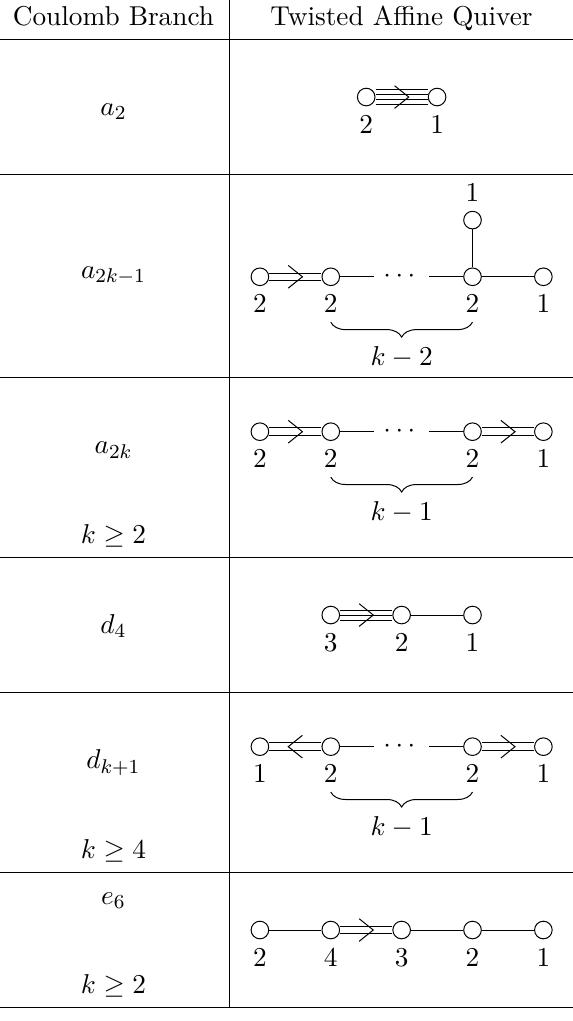
of the semi-simple Lie groups G , of the k k